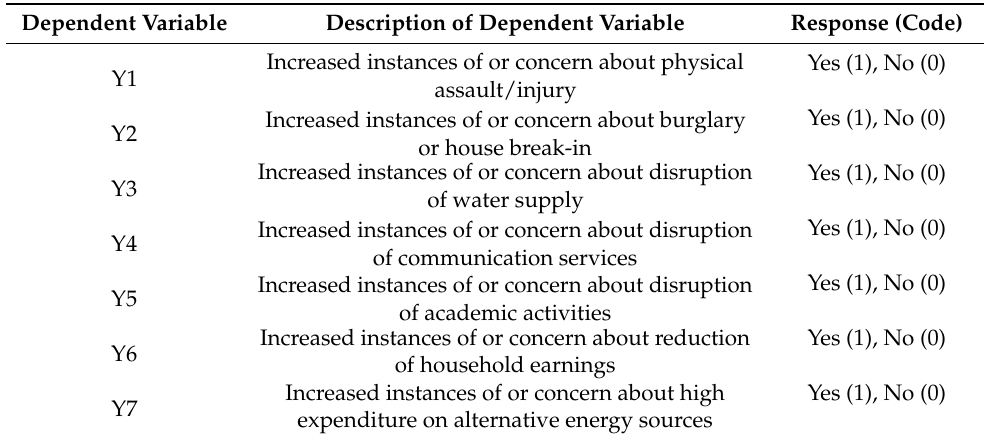
Table 2. Select impacts of outages in Accra